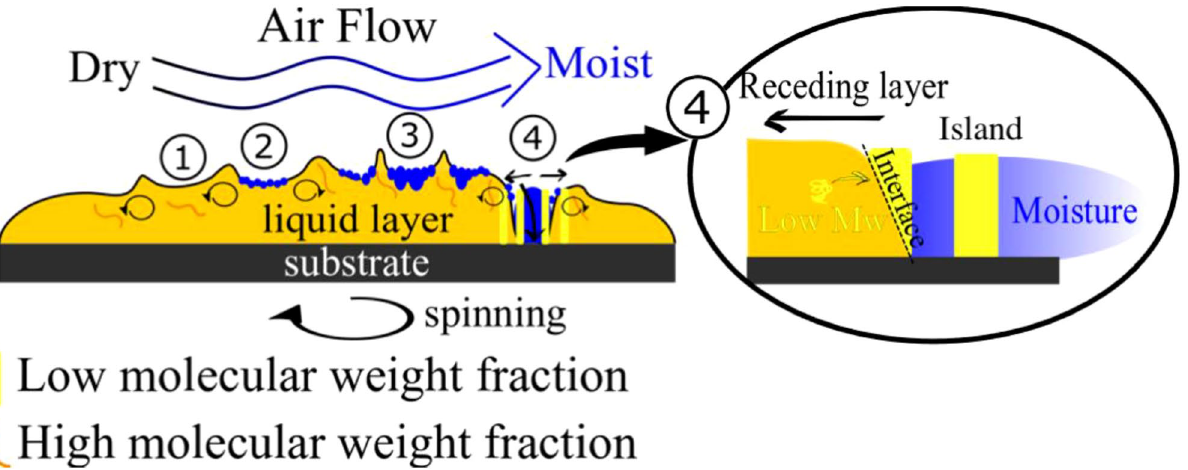
Figure 12. Four scenarios of phase separation: spin-coating in dry air ((1), 0% Rh); moderate humidity ((2), 45% Rh; (3), 55% Rh); and high humidity ((4), 75% Rh). Low and high molecular weight fractions, convective flow driving honeycomb formation, and low molecular weight separation at the interface between the water- wetted rupture and the liquid layer of the polymer solution are presented. (Inkscape v0.92, https:// inksc ape.